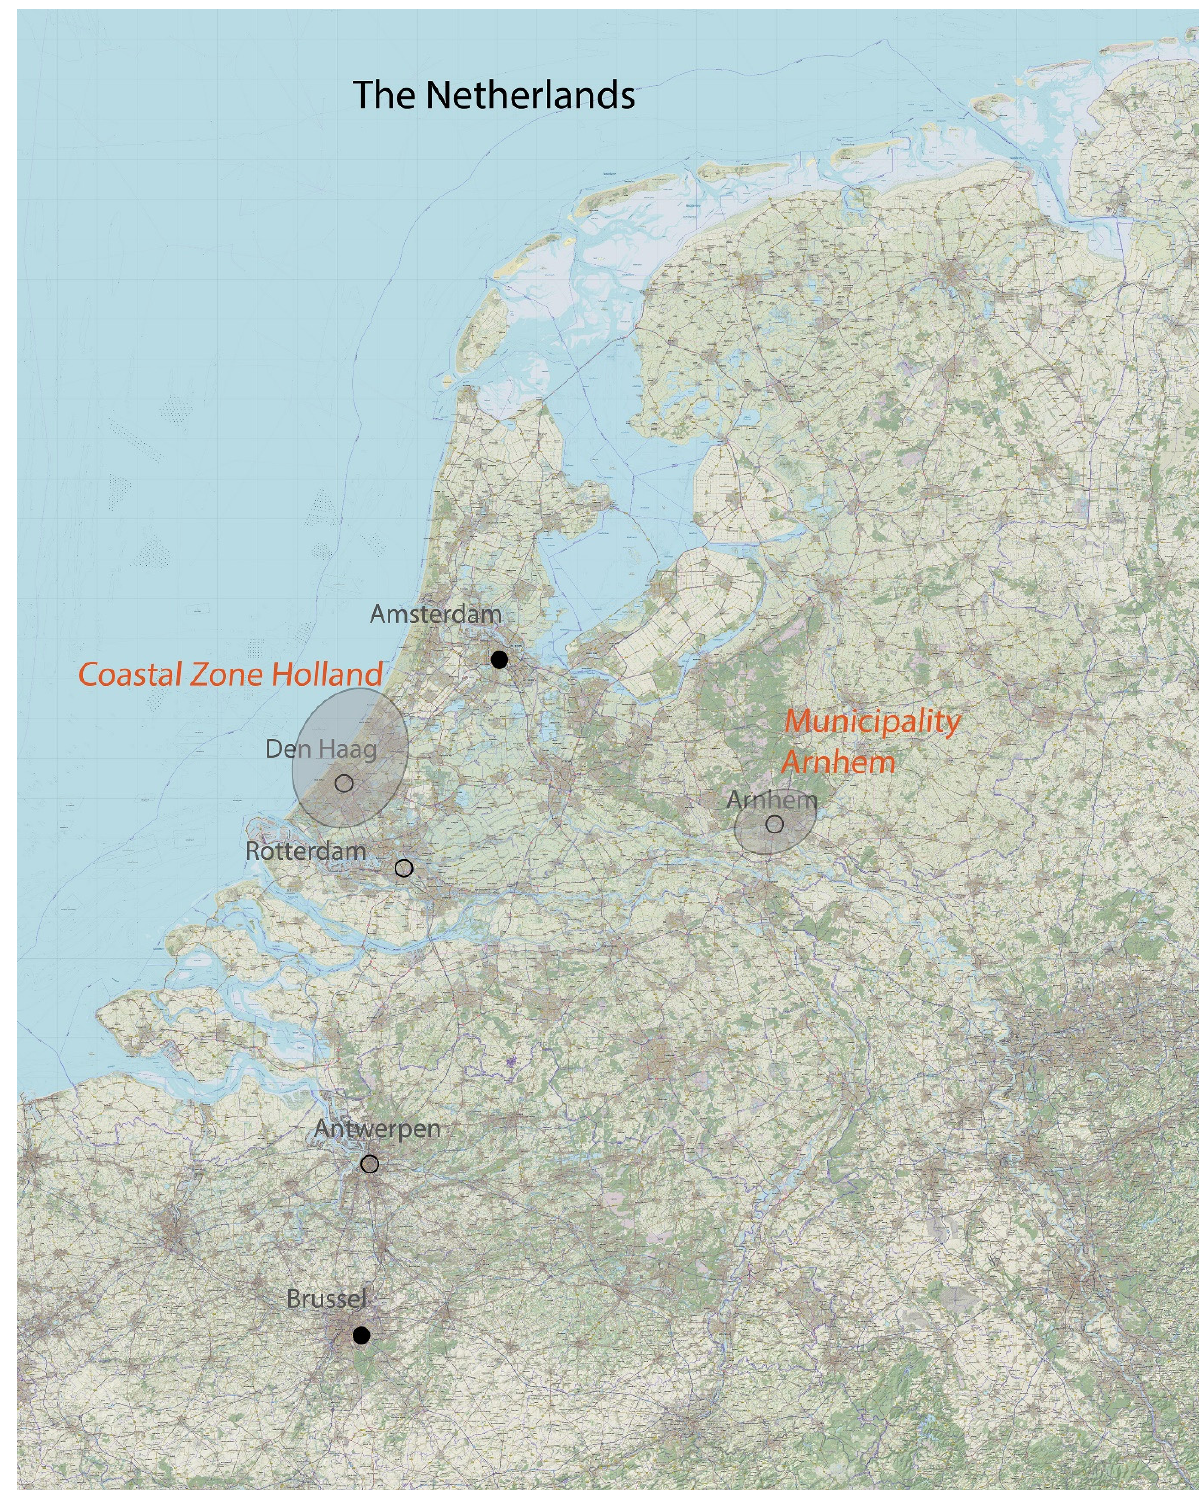
Figure 2. Map of the locations of the case studies in the Netherlands.